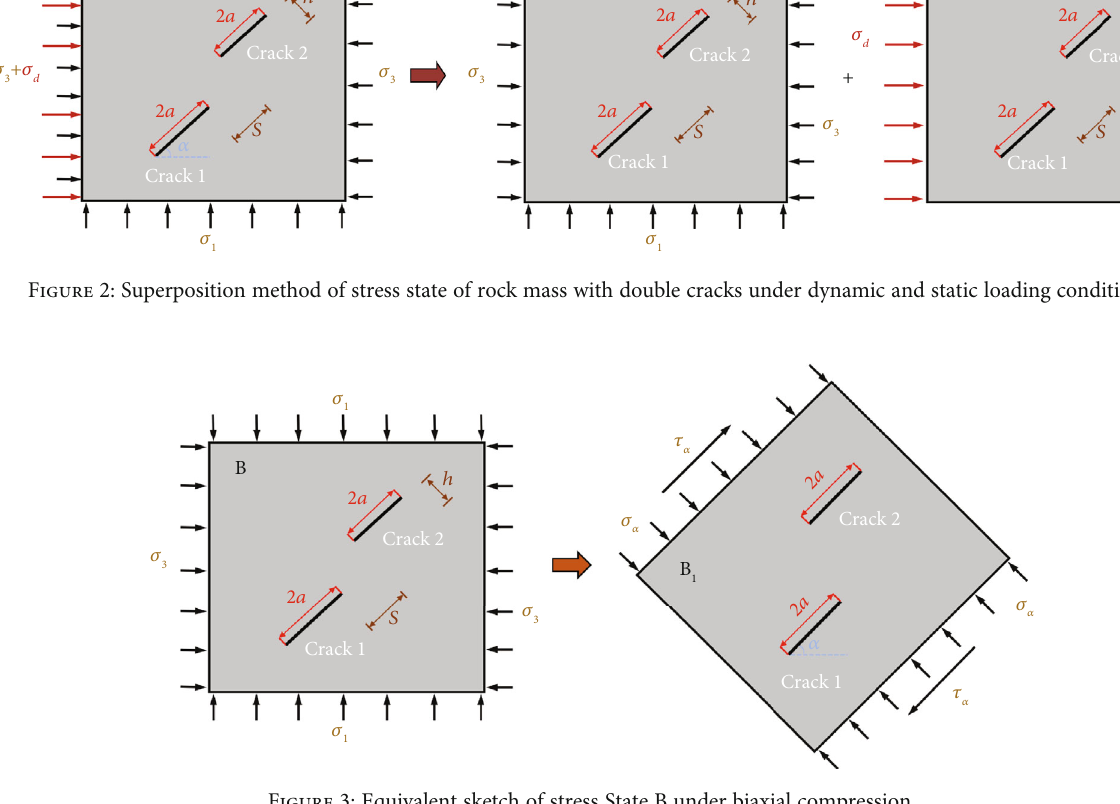
Figure 3: Equivalent sketch of stress State B under biaxial